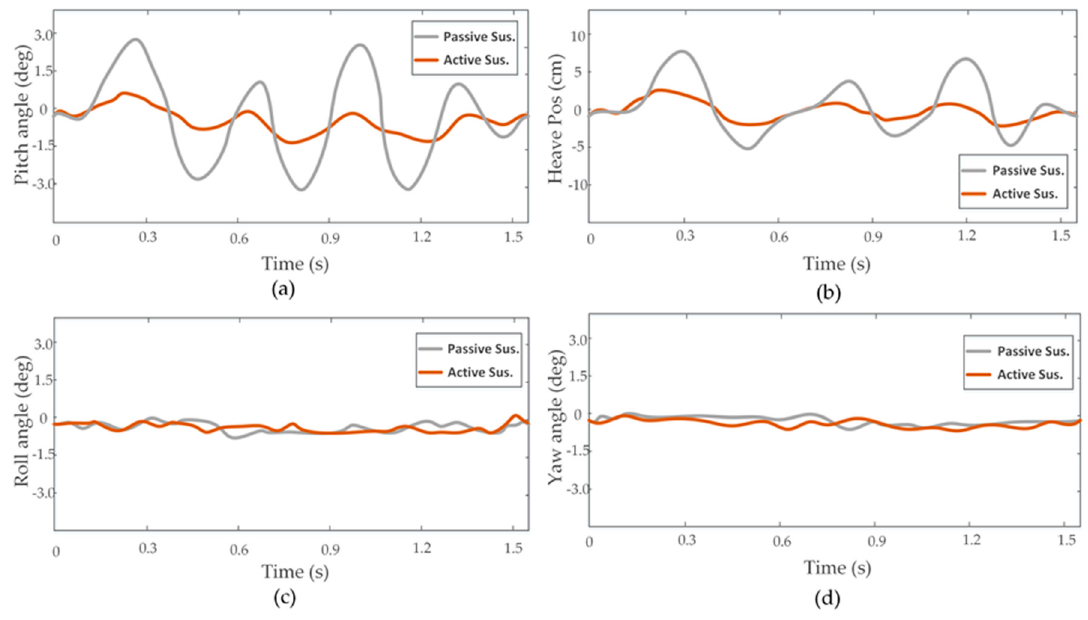
Figure 9. Time domain plots of heave, pitch, roll, and yaw data obtained by sensors. ( a ) Pitch angle. ( b ) Heave position. ( c ) Roll angle. ( d ) Yaw angle.